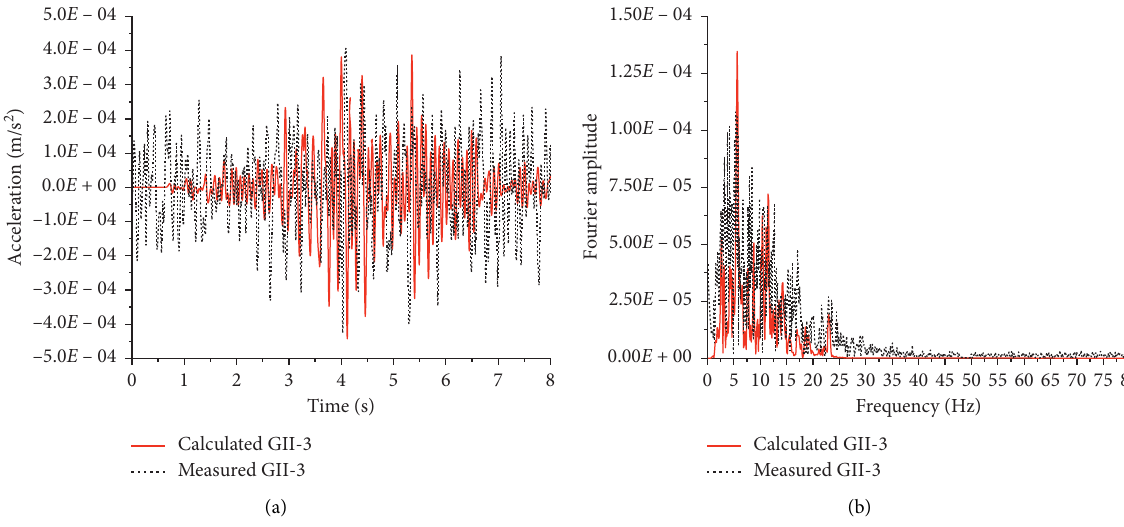
Figure 22: Comparison of numerical and field results (GII-3): (a) acceleration time history; (b) frequency spectrum.